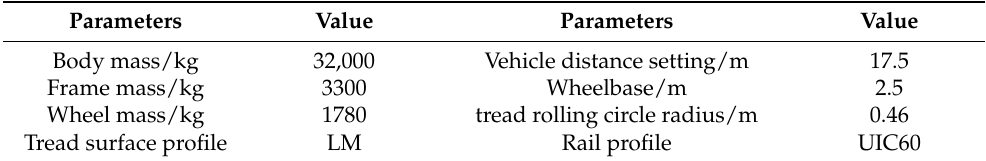
Table 2. Track alignment